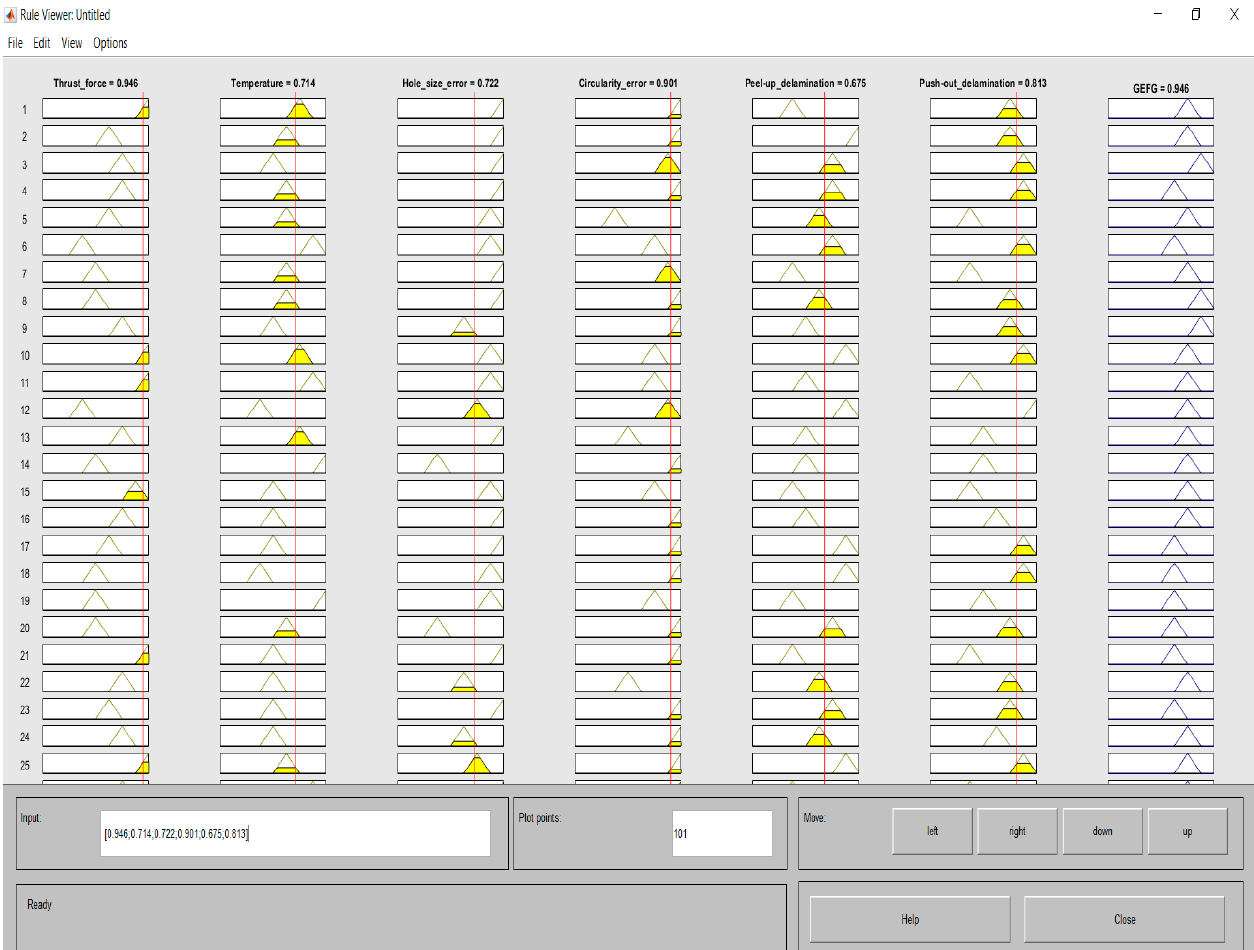
Figure 6. Membership functions for ( a ) input factors and ( b ) output GEFG.